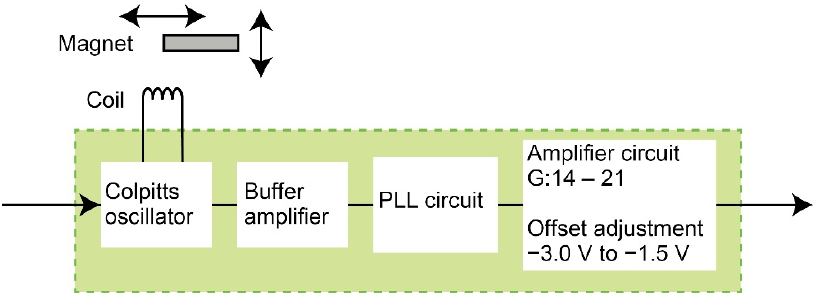
Figure 4. Schematic image of the noncontact displacement sensor. Sensors 2021 , 21 , x FOR PEER REVIEW